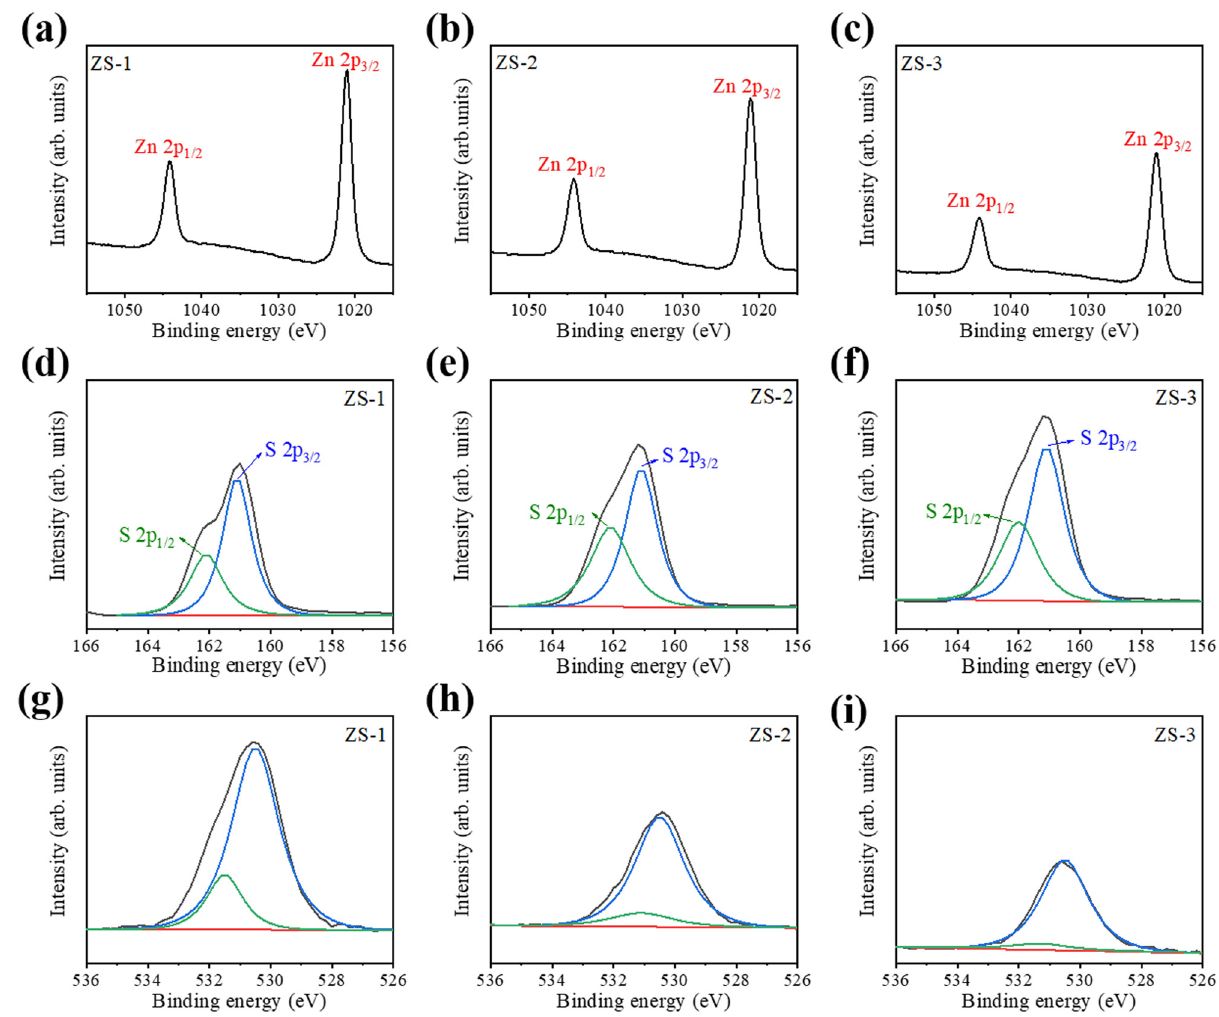
Figure 6: High - resolution XPS spectra in Zn2p: ( a ) ZS - 1, ( b ) ZS - 2, and ( c ) ZS - 3. High - resolution XPS spectra in S2p: ( d ) ZS - 1, ( e ) ZS - 2, and ( f ) ZS - 3. High - resolution XPS spectra in O1s: ( g ) ZS - 1, ( h ) ZS - 2, and ( i ) ZS - 3.